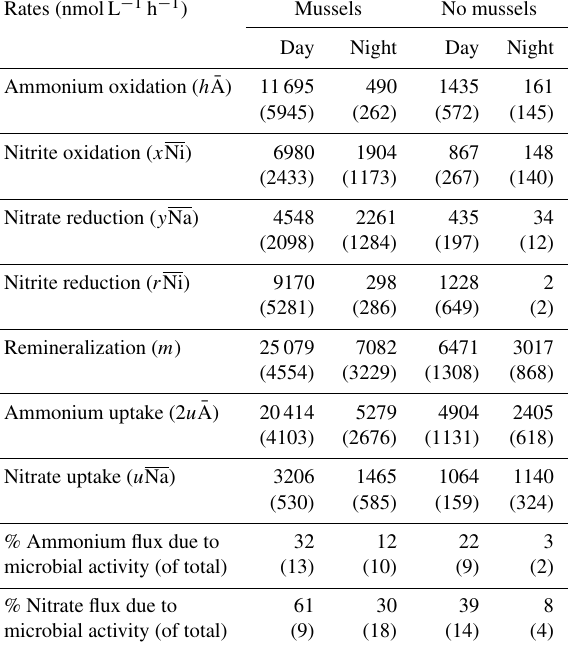
Table 3. A summary of all estimated rates by treatment in the ODE model (Eqs. 2–7). Means and (se) are shown with n = 10 per treat- ment. The contribution of microbial transformations to overall am- monium and nitrate fluxes was quantified as the percentage that mi- crobial activity (NH + oxidation, NO − reduction, NO − oxidation 4 3 2 and reduction) contributed to all nitrogen uptake, including nitro- gen uptake of phototrophs ( u